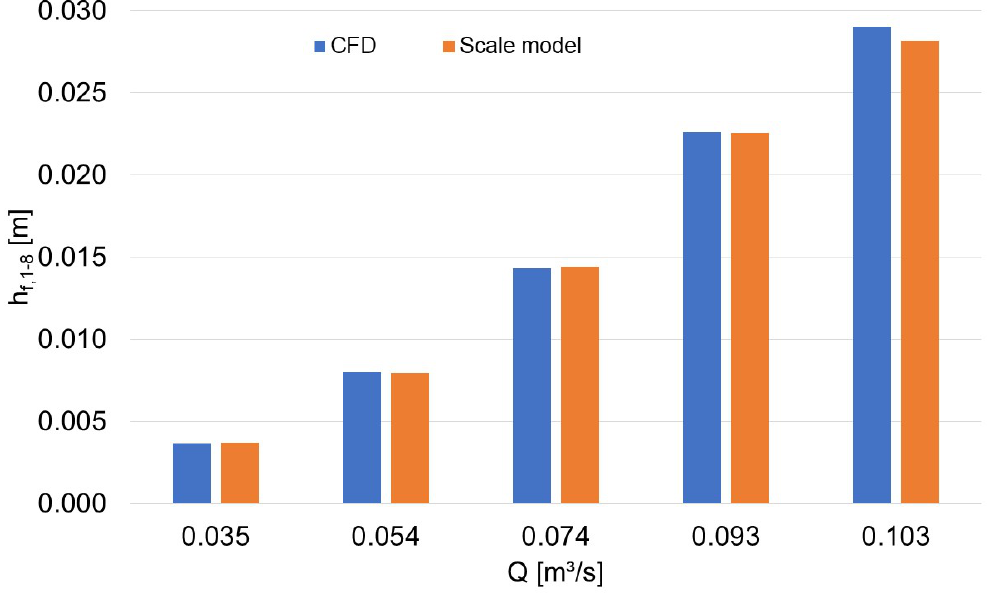
Figure 8. Comparison of total head losses in the tunnel from physical and numerical study (the model was calibrated for Q = 0.035 m 3 / s and the further simulations were carried out with the same parameterizations).